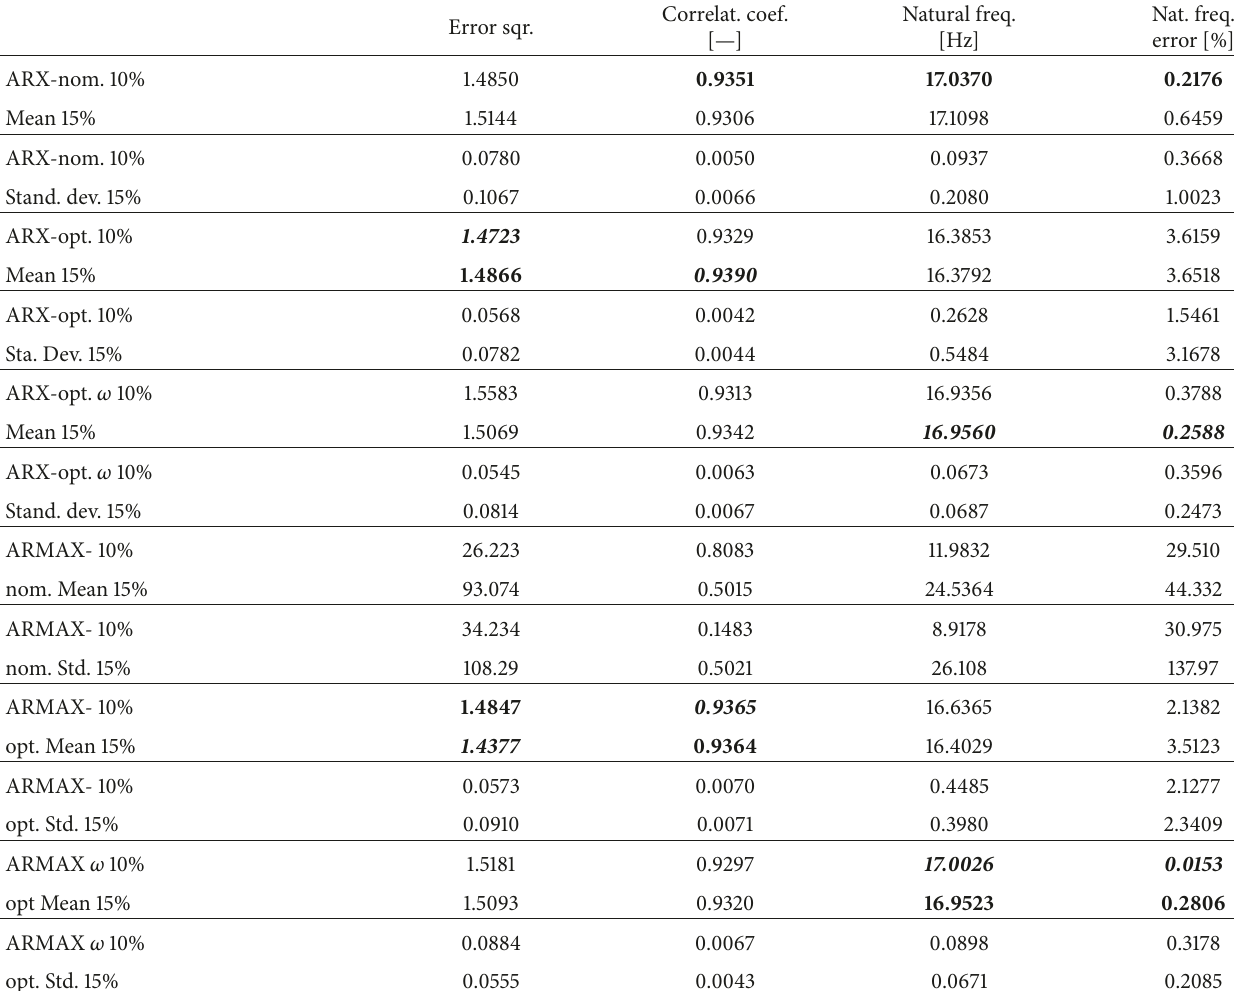
Table 3: Simulation results with 10% and 15% noise standard